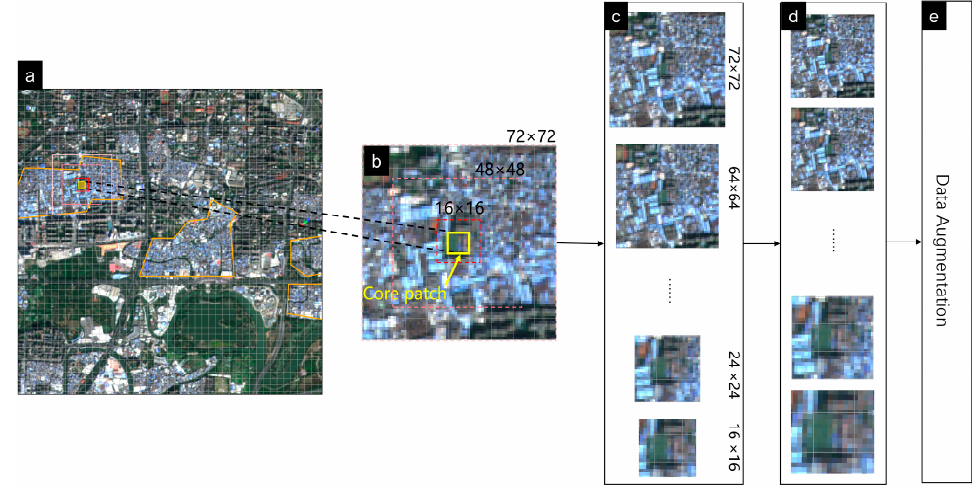
Figure 2. The steps of building sequential virtual scenes (SVS) for samples ( a – e ).